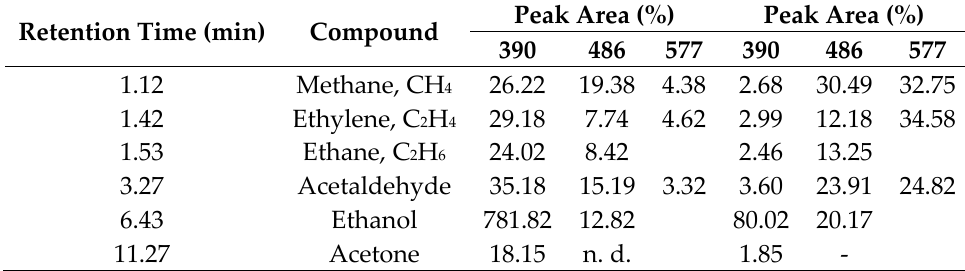
Table A1. Results of GC/FID